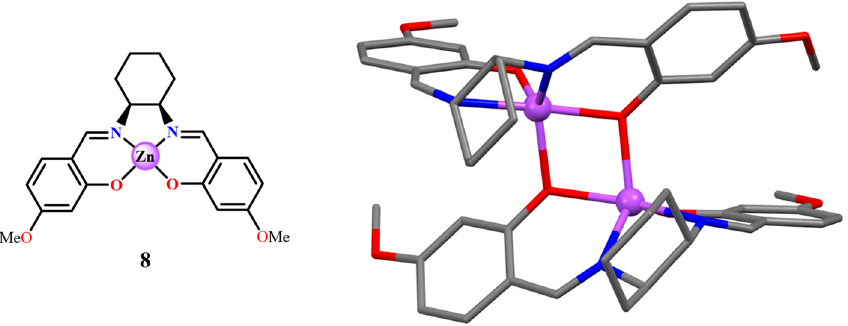
Figure 6. Molecular drawing of the 4-OMe substituted Zn(salchx) complex 8 ( left ), and crystal structure of the (8) 2 dimer ( right ). Adapted from Ref. [36].